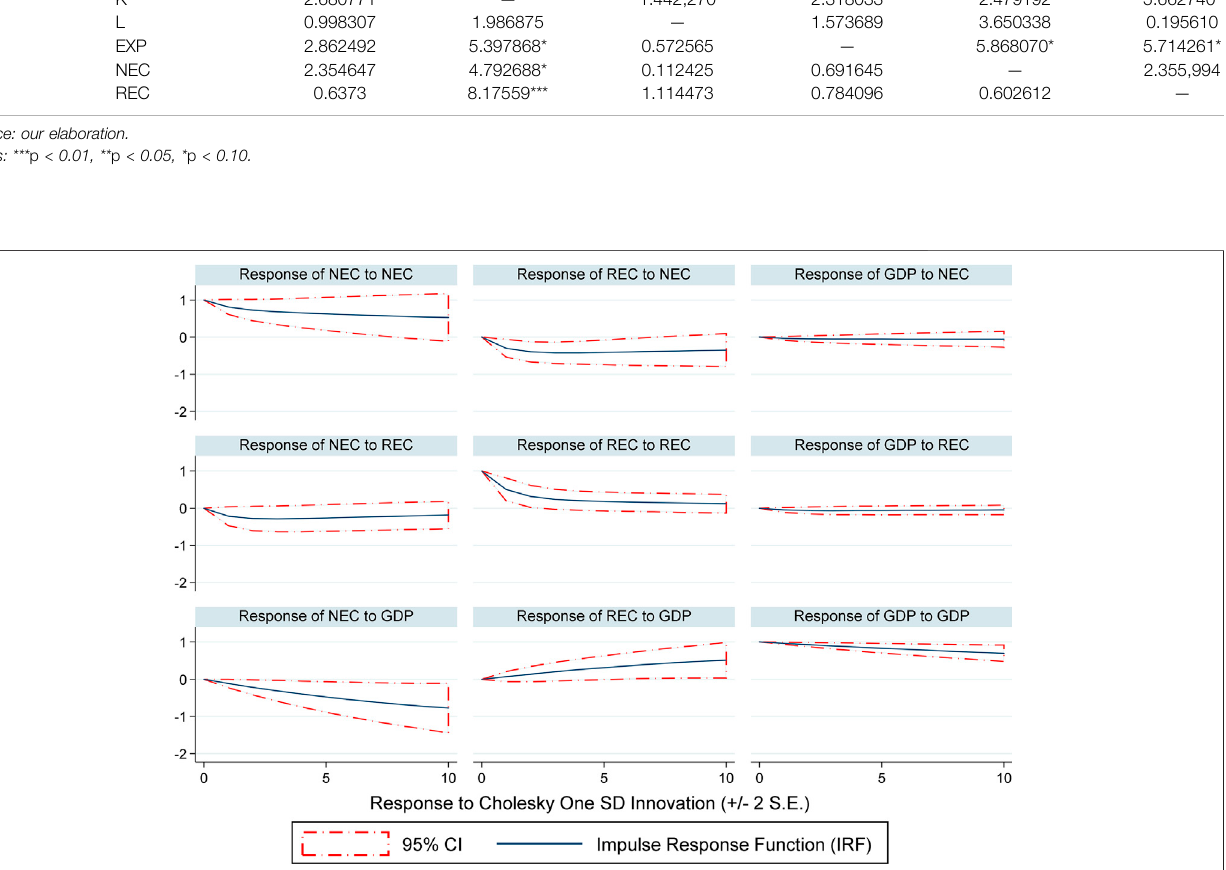
Frontiers in Environmental Science |